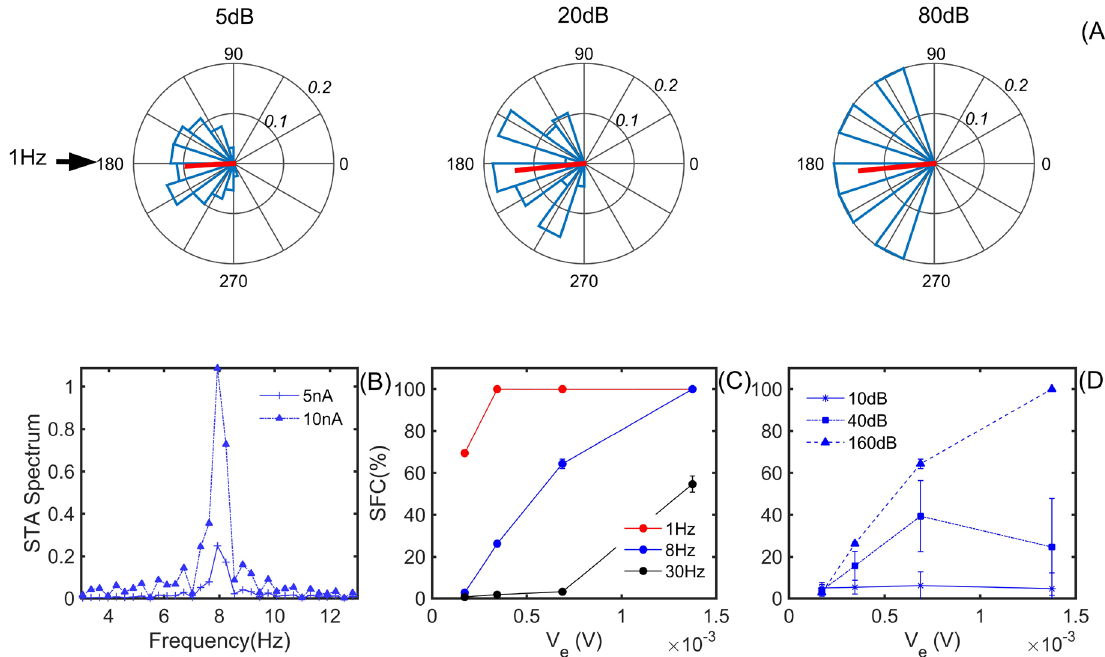
Figure 3. Results of the suprathreshold regimen. In panel ( A ) we show the population vector (spike phase preference) for a 1 Hz frequency and 10 nA amplitude of external stimulus. The noise does not change the direction of the population vector (for complete analysis with different frequencies, amplitudes and noises see Supplementary Figs. 5 and 6 in Supplementary Information). In ( B ) we observed that the intensity of the STA spectrum, given a frequency (8 Hz), is directly related to the signal intensity (5 nA and 10 nA). For this test the peaks occur with a frequency equal to that of the supplied stimulus, of 8 Hz. The outcomes for 1 Hz and 30 Hz, with 1.25, 2.5, 5 and 10 nA were observed in Supplementary Fig. 7 in Supplementary Information. ( C ) The SFC (entrainment intensity) results indicate that the higher the frequency of the stimulus signal (30Hz—in black), the less intense is the entrainment between the peaks and the external stimulus. Otherwise, for the frequency equal to 1 Hz, the SFC assumes a high value (in red). In panel ( D ) the SFC, for 8 Hz, were calculated for different noise intensities (10 dB, 40 dB and 160 dB) in the external signal. For the same analysis for 1 Hz and 30 Hz, see Supplementary Fig. 8 in Supplementary Information. Our results are similar to empirical